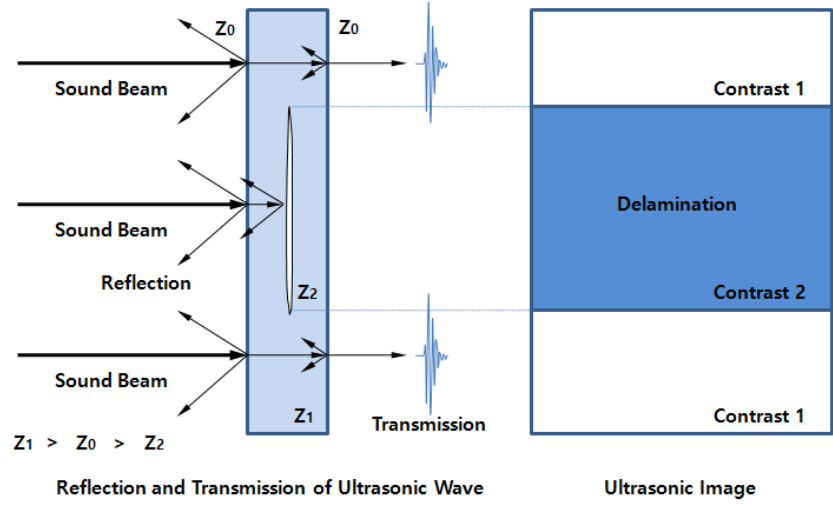
Figure 3. Ultrasonic image obtained from a delamination layer.